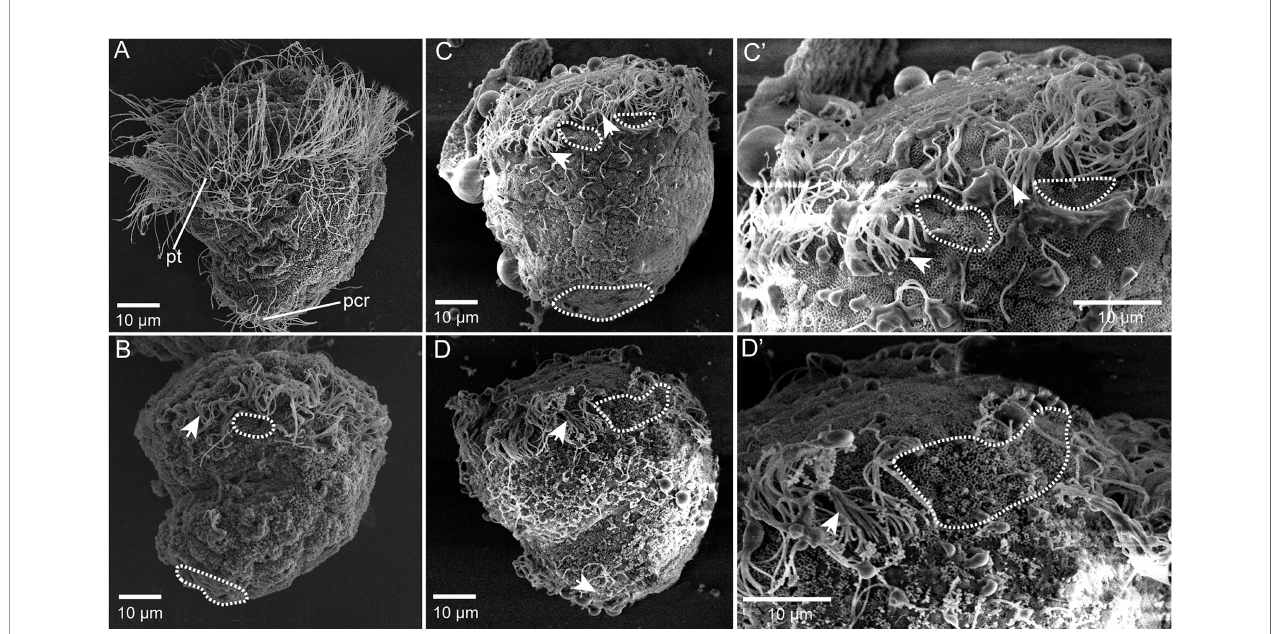
FIGURE 6 | Mosaic ciliary defects in the b -tubulin knockout larvae based on SEM. (A) Wild-type control, normally developing larvae under ordinary light microscopy. pt, peritroch. (B – D ’ ) Mosaic ciliary defects in the manipulated larvae based on the SEM data, including shortened (white arrows) and almost complete depleted cilia (white dotted boxes) at the positions of peritroch (B, C, C ’ , D, D ’ ) and the posterior cilium ring (B – D) of C . gigas angulate trochophore.